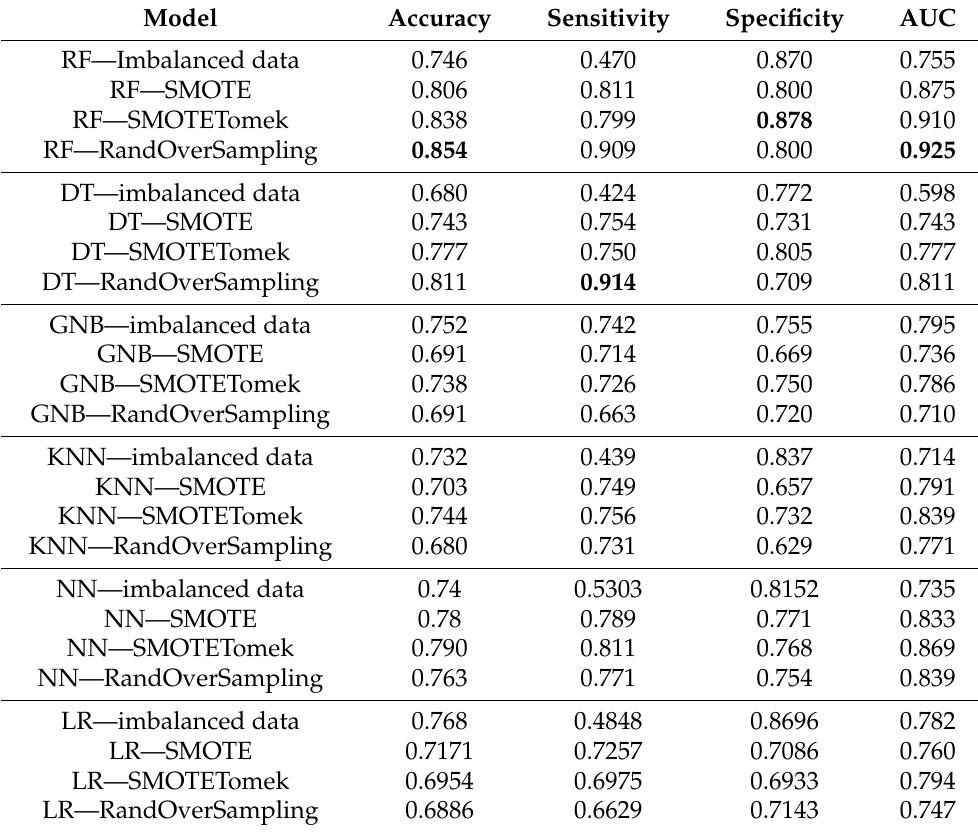
Table 4. Chi-squared feature selection with different classification algorithms. Values in bold are the maximum of each